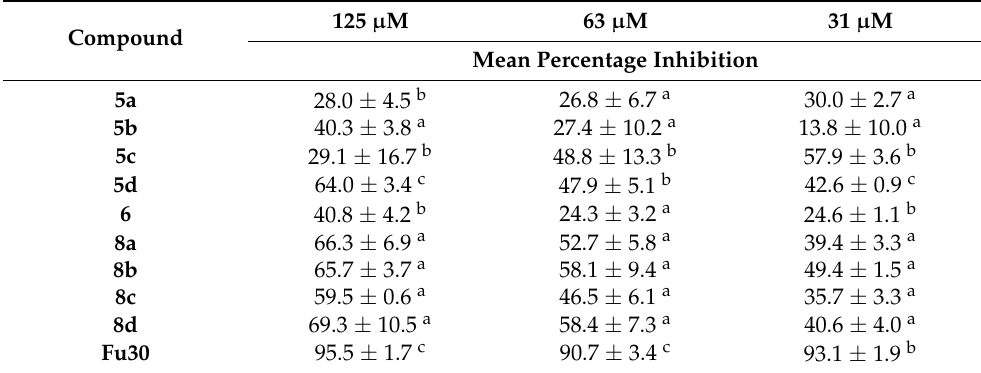
Table 1. QSI inhibition assay on LasR system of P. aeruginosa using percentage of GFP fluorescence at 485 nm in P las B:: gfp (ASV). All measurements were taken from at least two independent tests carried out in triplicates with ± standard deviation from mean.